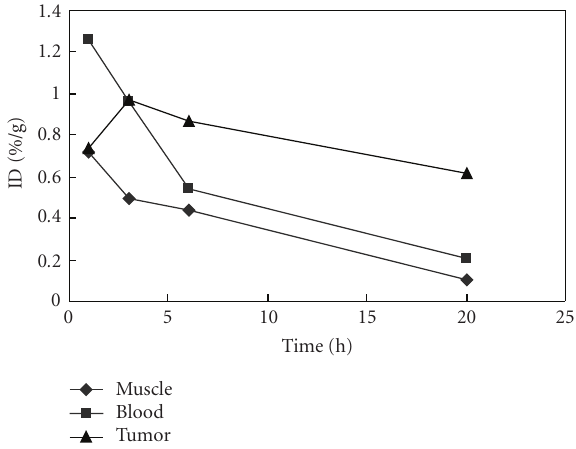
Figure 3: ID %/g of compound 5 in tumor, muscle, and blood at di ff erent time